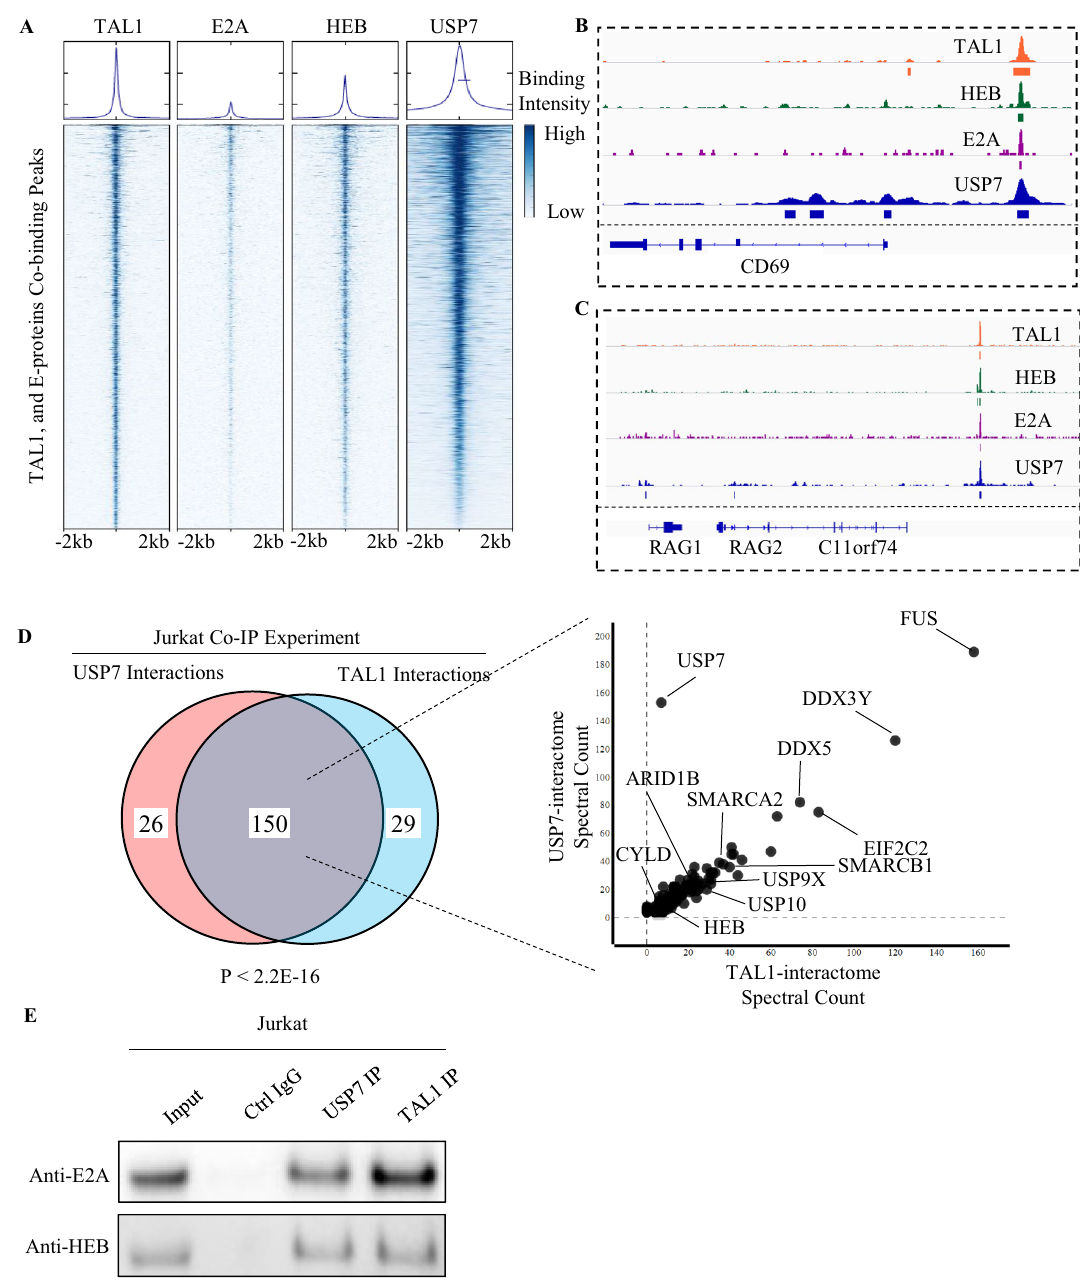
Figure 4. USP7 co-localizes with TAL1, E2A, and HEB in the Jurkat cell line. ( A ) Density heatmap showing that the majority of the peaks from TAL1, E2A, and HEB ChIP-seq overlap with those of USP7. ( B ) Representative TAL1, HEB, E2A, and USP7 peaks proximal to the CD69 gene body. ( C ) Representative TAL1, HEB, E2A, and USP7 peaks proximal to the RAG1/2 gene body. ( D ) Affinity purification-mass spectrometry using USP7 and TAL1 as bait proteins. Venn diagram (left) shows the overlap of USP7 and TAL1 interacting proteins. P-value was calculated based on a two-sided Fishers-exact test. Spectral counts of USP7 and TAL1 interacting proteins are shown on the right. ( E ) Serial co-IP Western blotting showing the interaction of USP7/ TAL1 and E